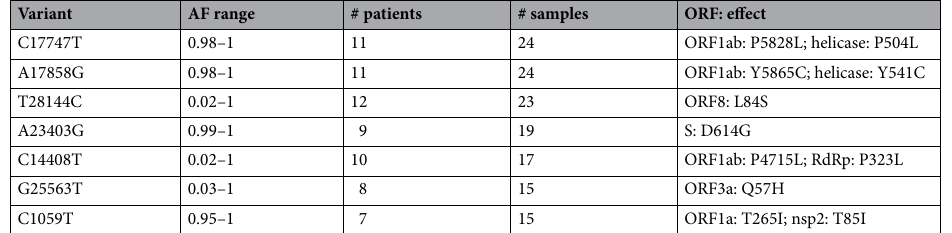
Table 3. Frequent non-synonymous variants observed in ≥ 15 samples (n = 47). All variants called had at least 10 reads of support for the alternate allele. For the three variants with large ranges in allele frequency (T28144C, C14408T, G14408T), ≤ 3 outlier samples with variant AFs below 0.1 were present. When these samples are excluded, minimum AF increases to ≥